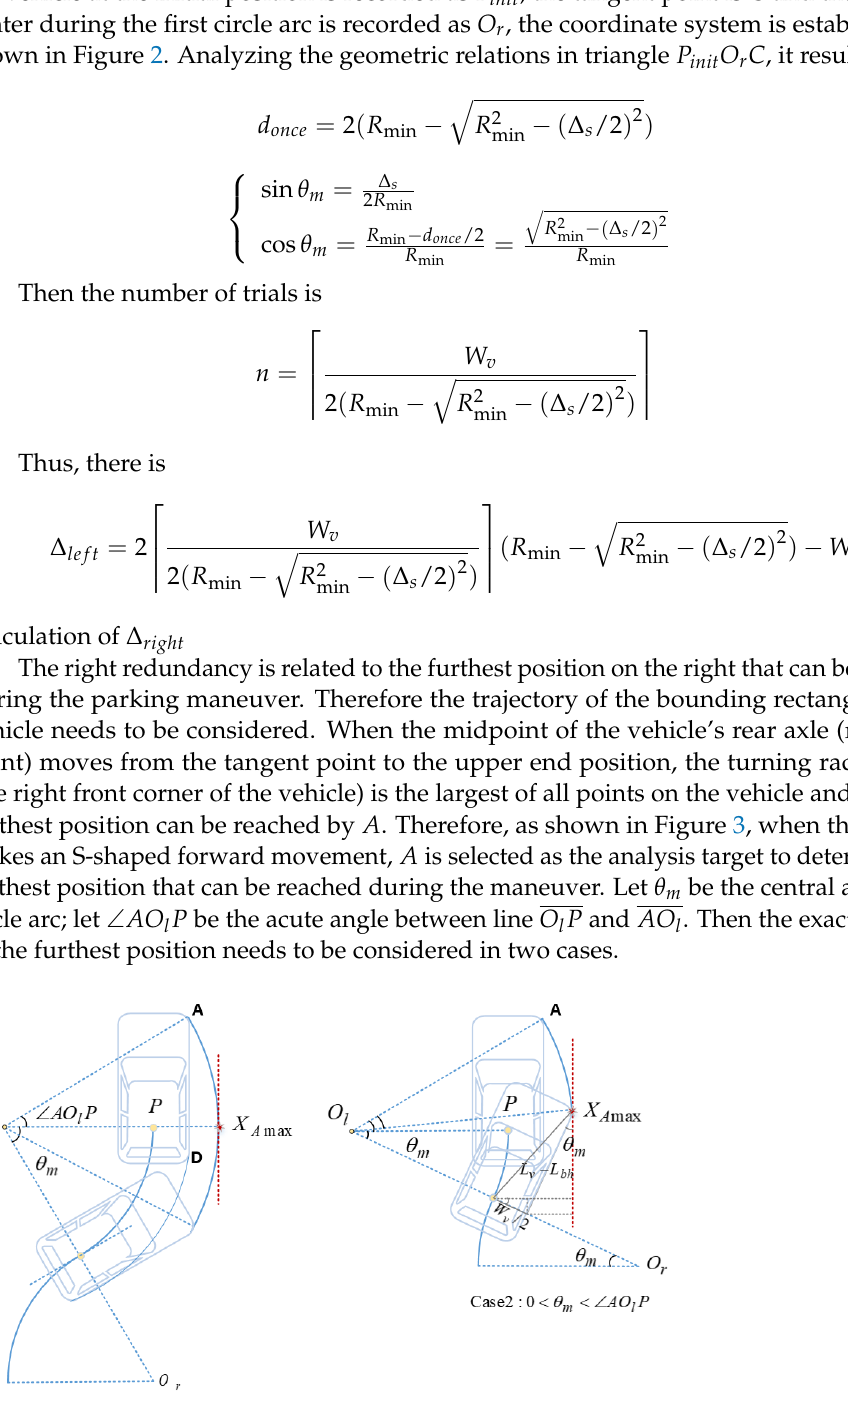
(cid:10) (cid:11) O l , R O with O l and R O l A l